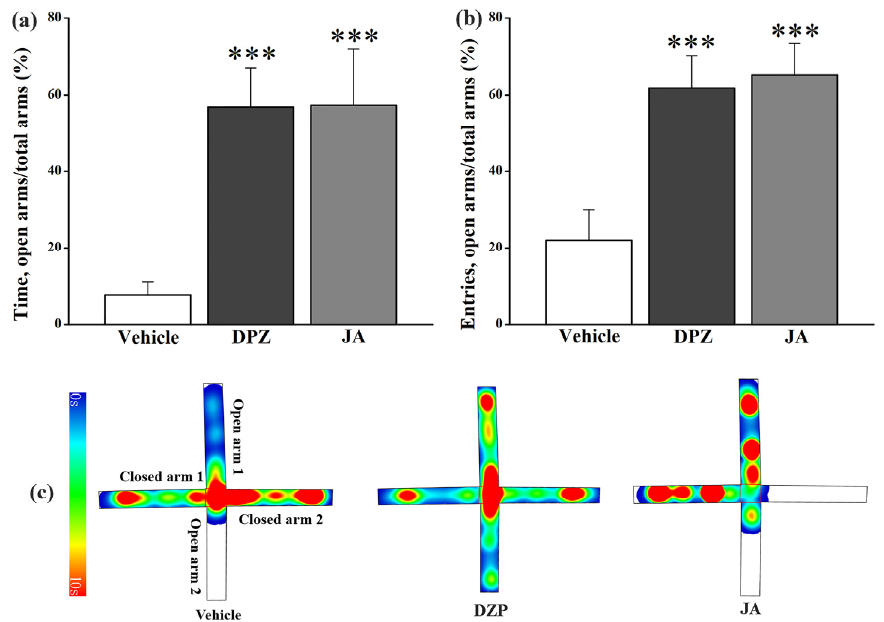
Figure 9. Effects of jegosaponin A (JA) at 3 mg/kg on the percentage of time in open arms ( a ) and the percentage of entries into open arms ( b ) in the elevated plus maze test. Heatmaps of mice in vehicle, DZP and JA groups ( c ). Vehicle: blank control, DZP: diazepam. Data are displayed as mean ± SD. *** p < 0.001 vs. vehicle group.